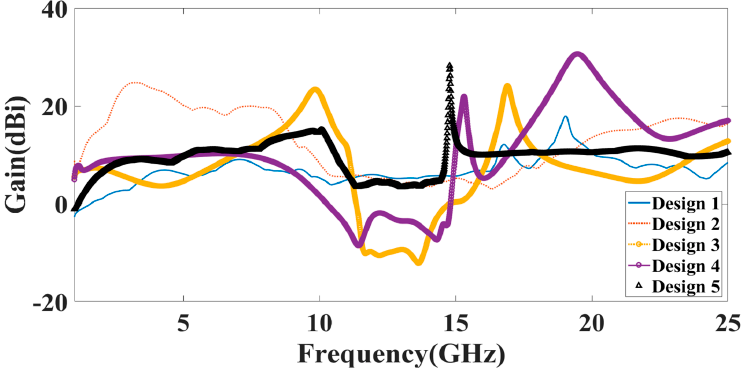
Figure 5. Calculated values of the gain for the di ff erent antenna design for the frequency range of 1 to 25 GHz.